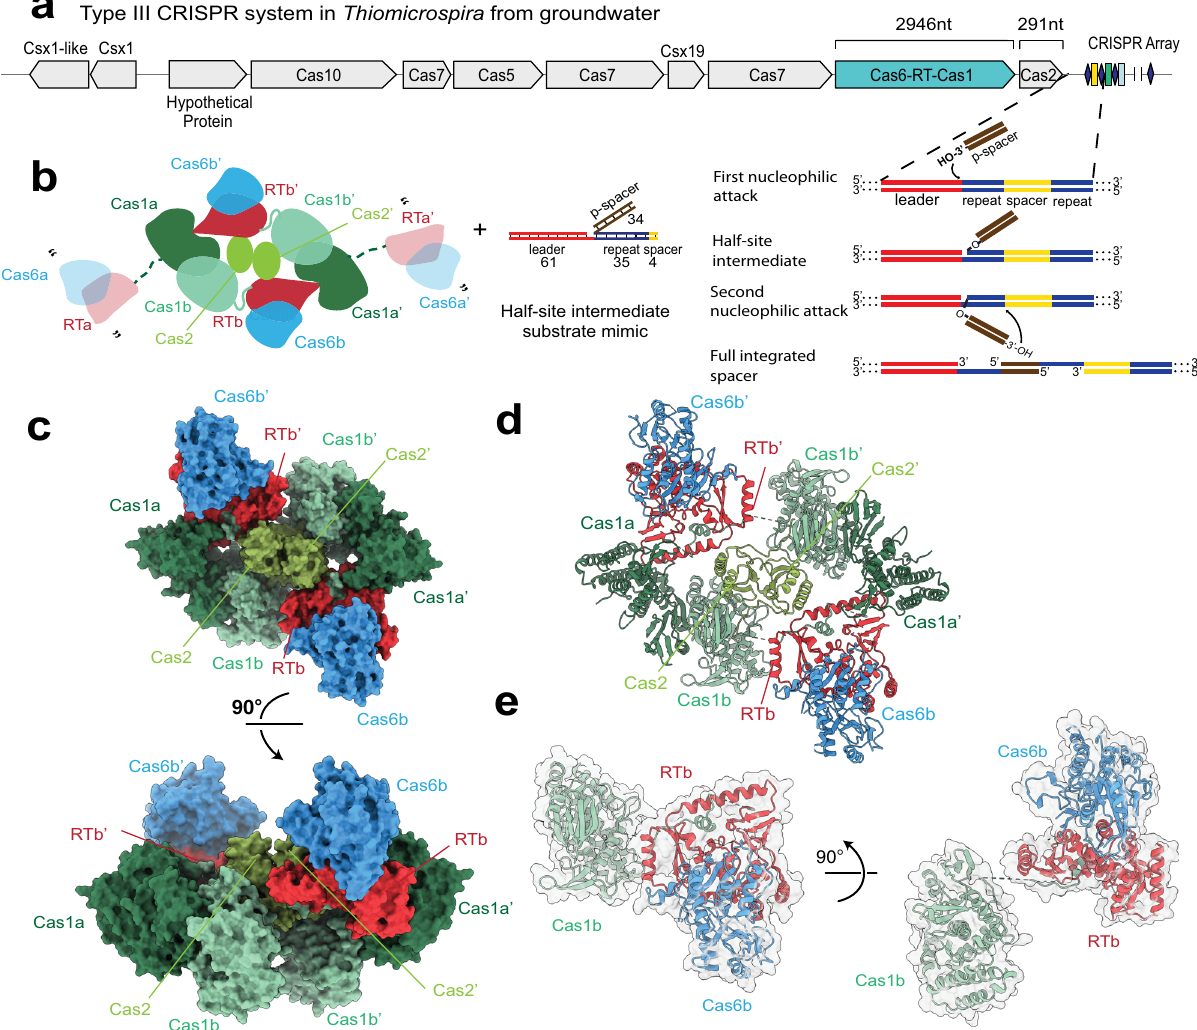
Fig. 1 A natural Cas6-RT-Cas1 fusion protein within a type III CRISPR-Cas system. a Illustration of the CRISPR genomic locus encoding the proteins used in this study and schematic of the CRISPR spacer integration reaction. Leader, red; repeat, blue; spacer, yellow; dsDNA protospacer (p-spacer), brown. b Cartoon showing Cas6-RT-Cas1 and Cas2 proteins and the DNA substrate, mimicking the half-site intermediate depicted in a , used in complex assembly. Proteins colored by domain: Cas6, blue; RT, red; Cas1a, dark green; Cas1b, turquoise; Cas2, lime green. Visible RT-Cas1 linkers are shown as solid turquoise lines. Missing Cas6-RT domains (Cas6a/RTa and Cas6a ’ /RTa ’ ) that are present in the complex but not visible are depicted as semi-transparent, connected to the rest of the structure by dashed dark green lines. Quotation marks indicate presumed mobility. Lengths of the DNA substrate strands are indicated. c Overall structure of the complex depicted in surface representation and 90° rotation, with color-coding as shown in b . d Overall structure of the complex, depicted in ribbon representation. e Architecture of a single Cas6-RT-Cas1 protomer and 90°